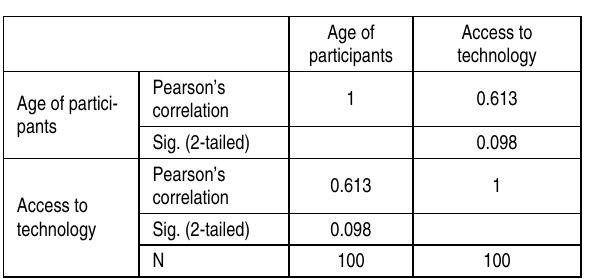
Age of participants